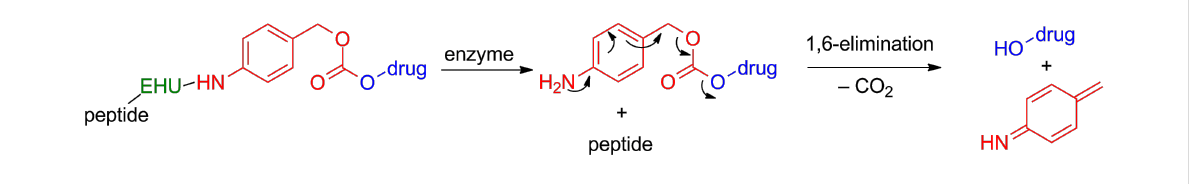
Figure 5: Illustration of the drug release mechanism from the self-immolative spacer PABC conjugated to a tumor homing peptide via an enzyme- hydrolyzable unit. Red color = the self-immolative spacer PABC; blue color = drug; green color = enzyme-hydrolyzable unit (EHU); black color the tumor-homing peptide.